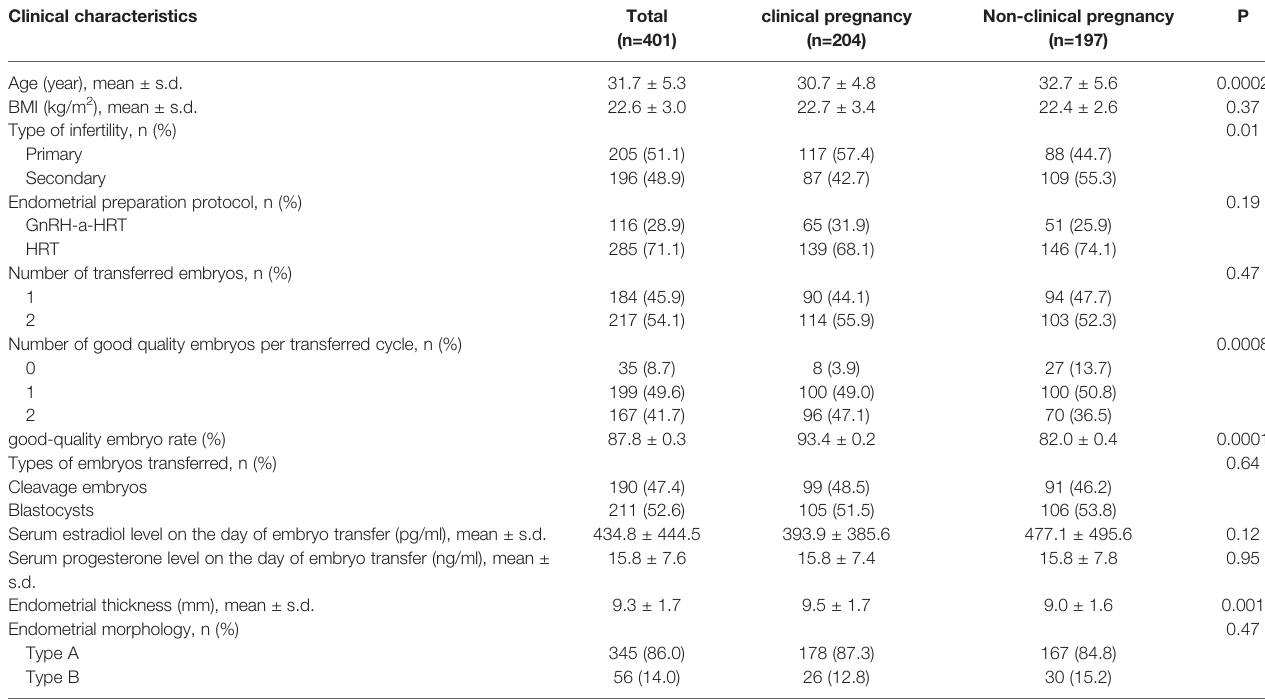
TABLE 1 | The clinical characters of the patients. Clinical characteristics